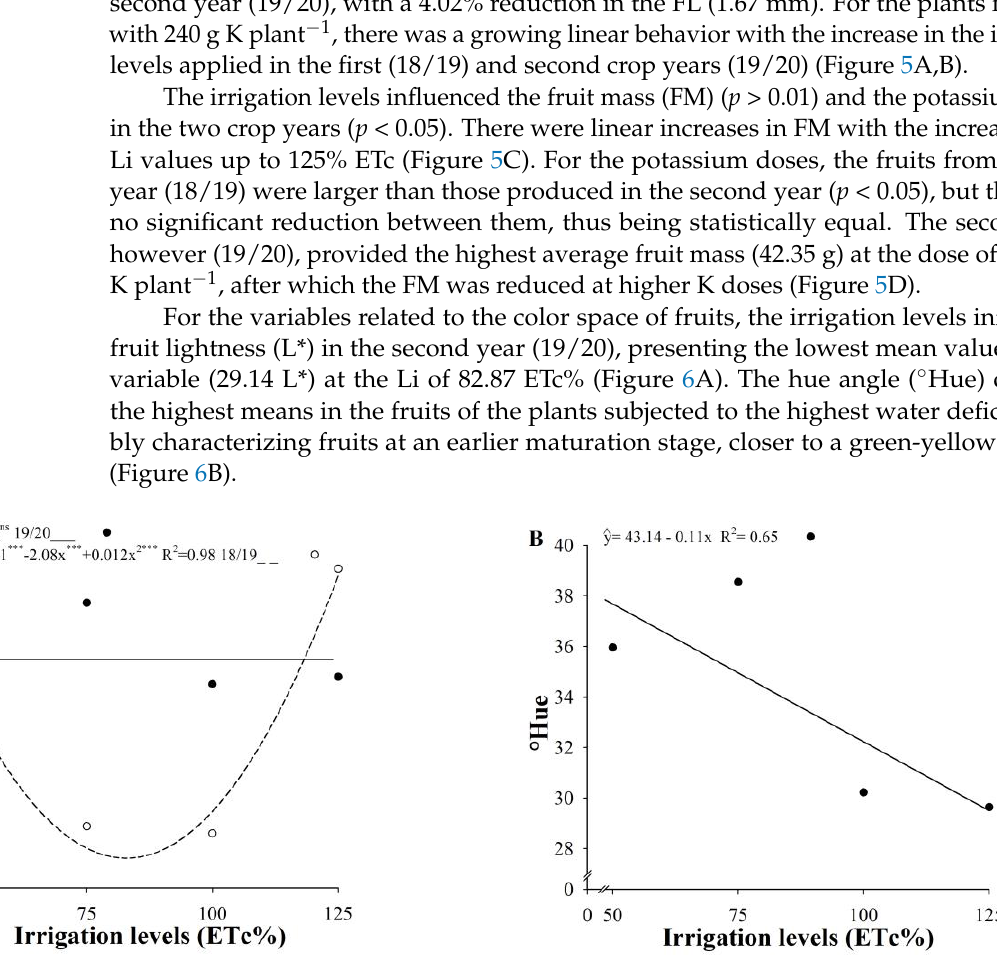
Figure 6. Lightness (L*) ( A ) and hue angle (°Hue) ( B ) of fruits as a function of the irrigation levels in fig plants grown under semiarid climatic conditions in the 2018/2019 and 2019/2020 crop years. ns Not significant ( p > 0.05); *** ( p < 0.001).